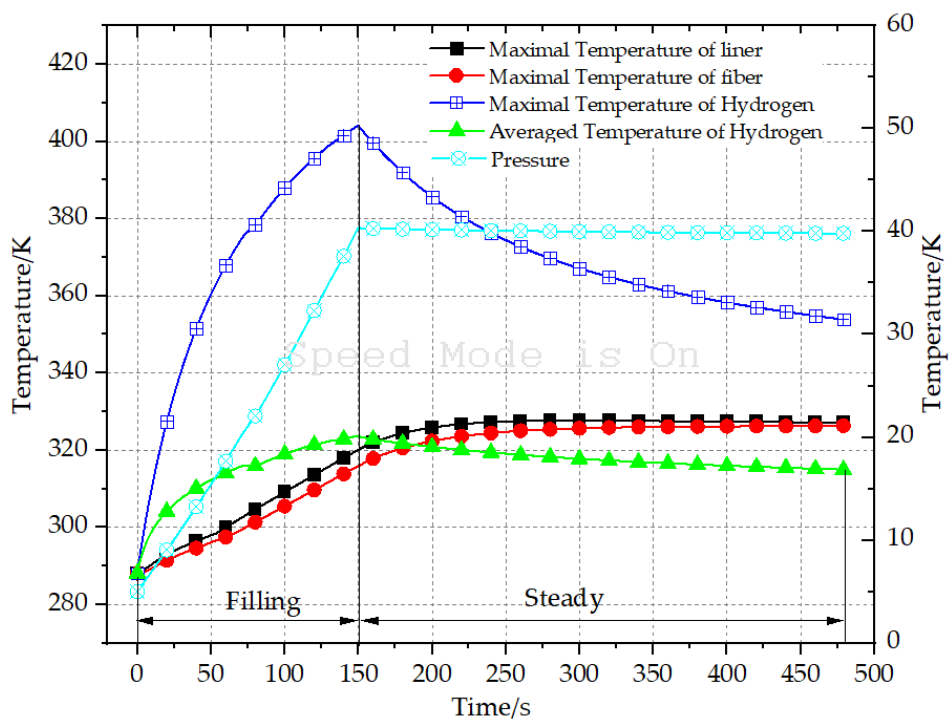
Figure 7. Monitored temperature evolution at different locations of the hydrogen tank.